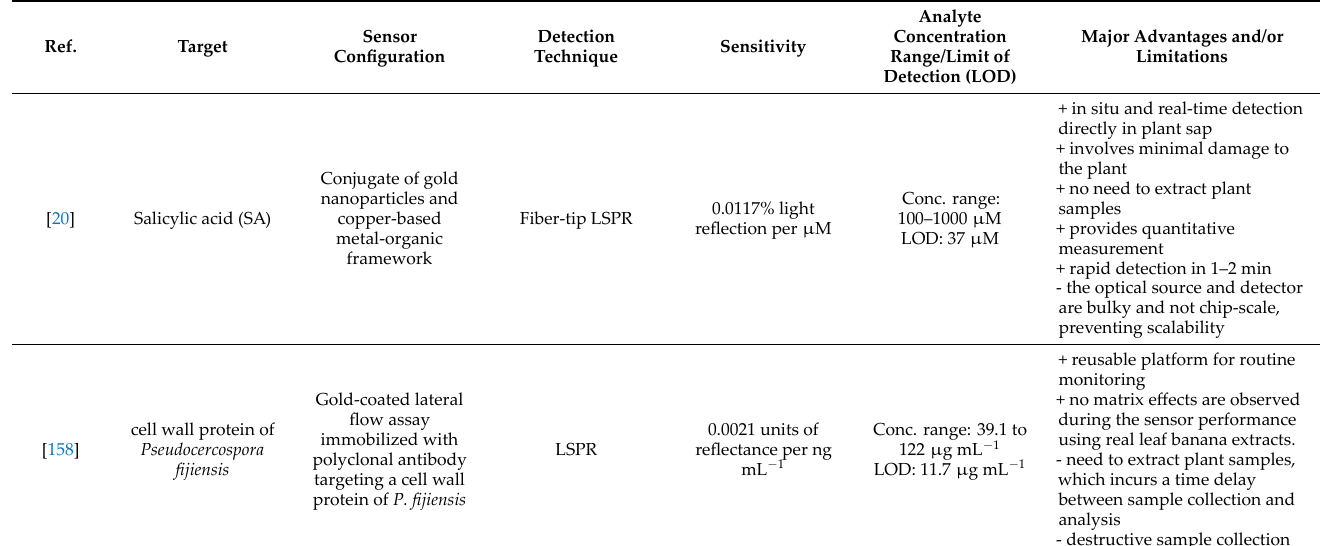
Table 2. Performance comparison of optical biosensing technologies for detecting plant microbial